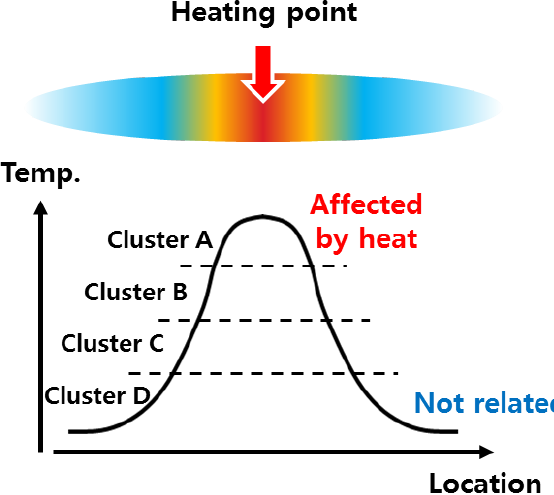
Figure 3. Spectral clustering algorithm (SCA) application for discretization in heat equation.